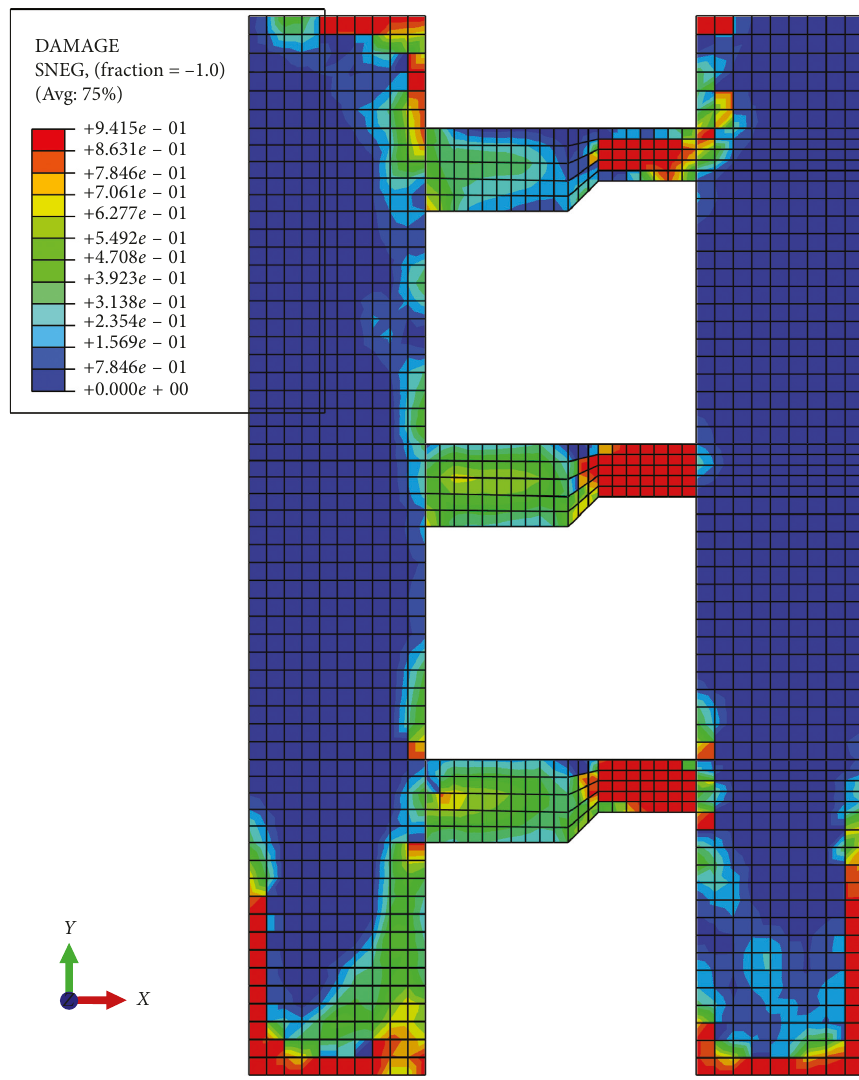
Figure 21: Damage status of the specimen. Table 5: Parameter values used in this